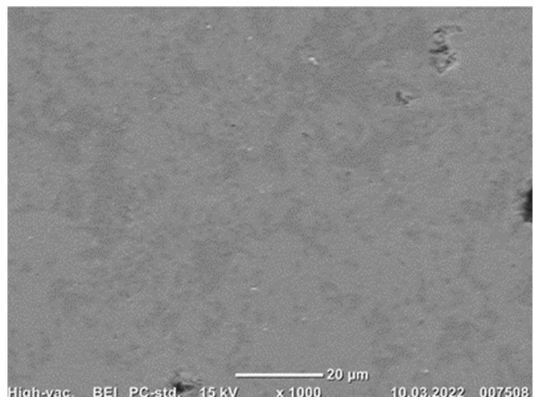
Figure 8. Typical SEM-BEI of sintered pellet.